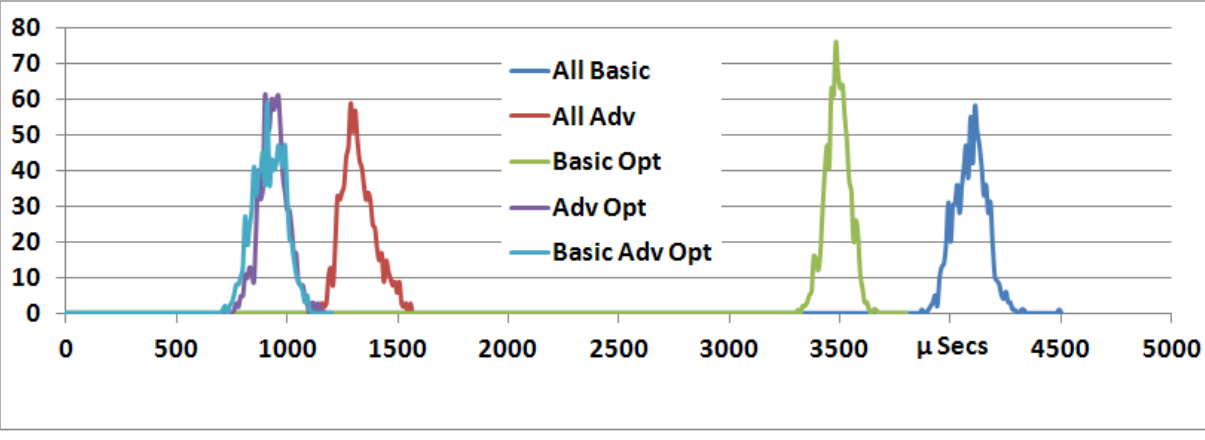
Figure 9. Measured values over the